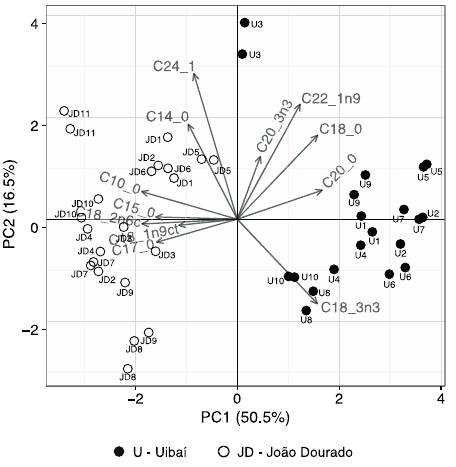
Figure 5. The first two principal component scores of the pollen’s fatty